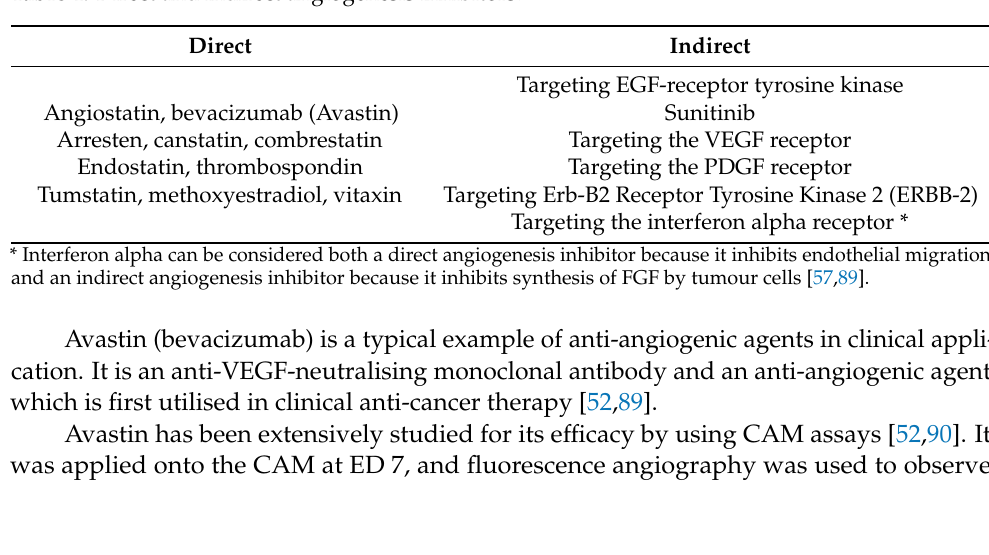
Table 4. Direct and indirect angiogenesis